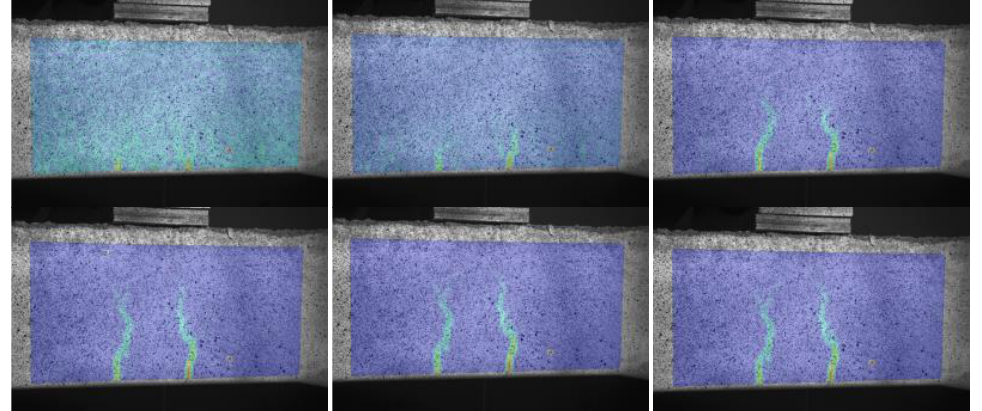
Figure 2. Setup of the static capacity test of the railway sleeper.